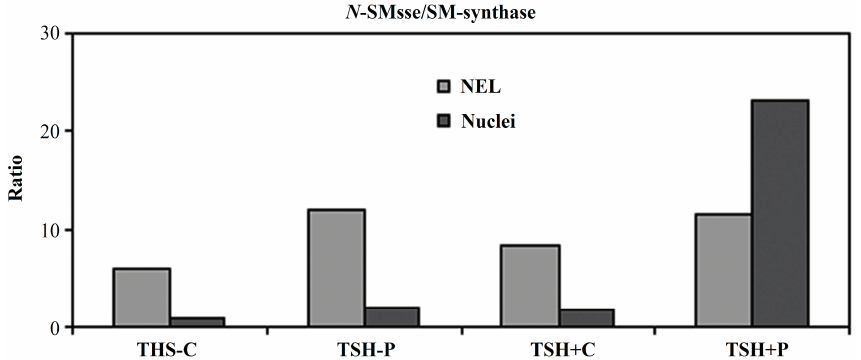
Figure 3. Effect of proton irradiation on neutral-sphingomyelinase/sphingomyelin-synthase ( N -SMase/SM-synthase) ratio of nuclei-free lysates (NFL) and purified nuclei (N) prepared from quiescent (TSH − ) and proliferating (TSH+) cells. C, control; P,